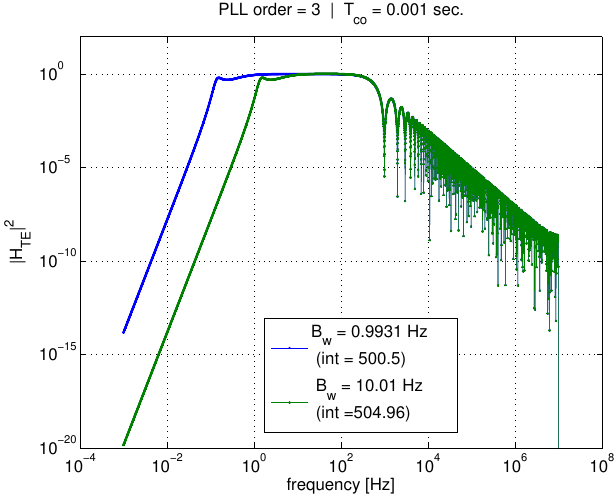
Figure 6. Effect of T co and PLL bandwidth on tracking error transfer function, 1 ms.